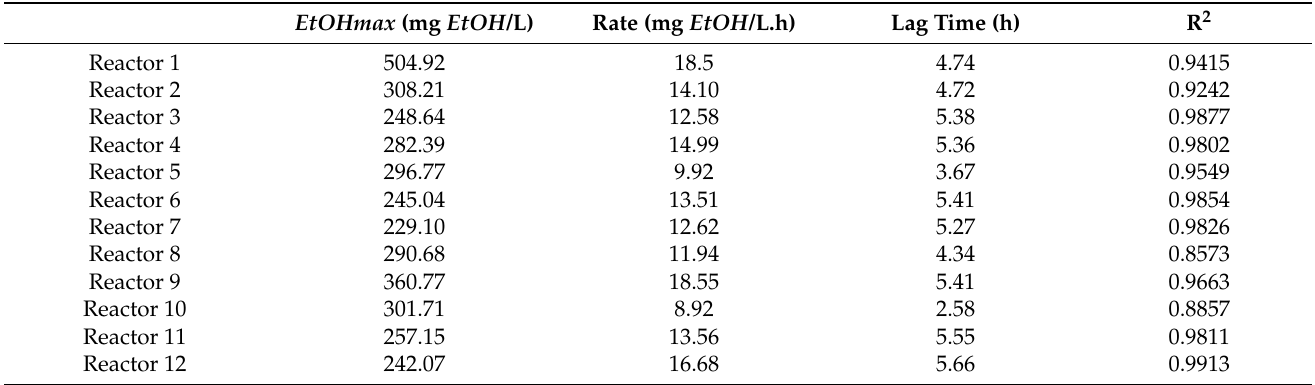
Table 5. Kinetic analysis on ethanol production using modified Gompertz